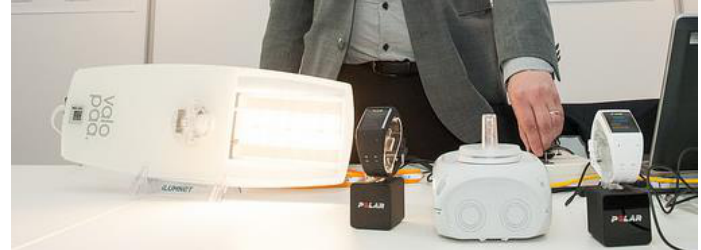
Figure 19. Polar and Valopaa devices of the smart mobile M2M demonstration in the digital innovation forum (DIF) event.